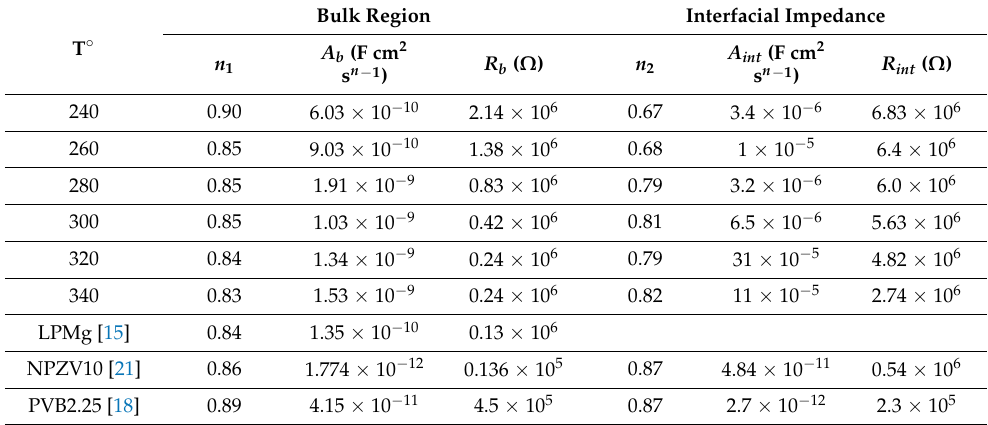
Table 1. The best-fitting values of equivalent circuit elements in Figure 7 for different temperatures.